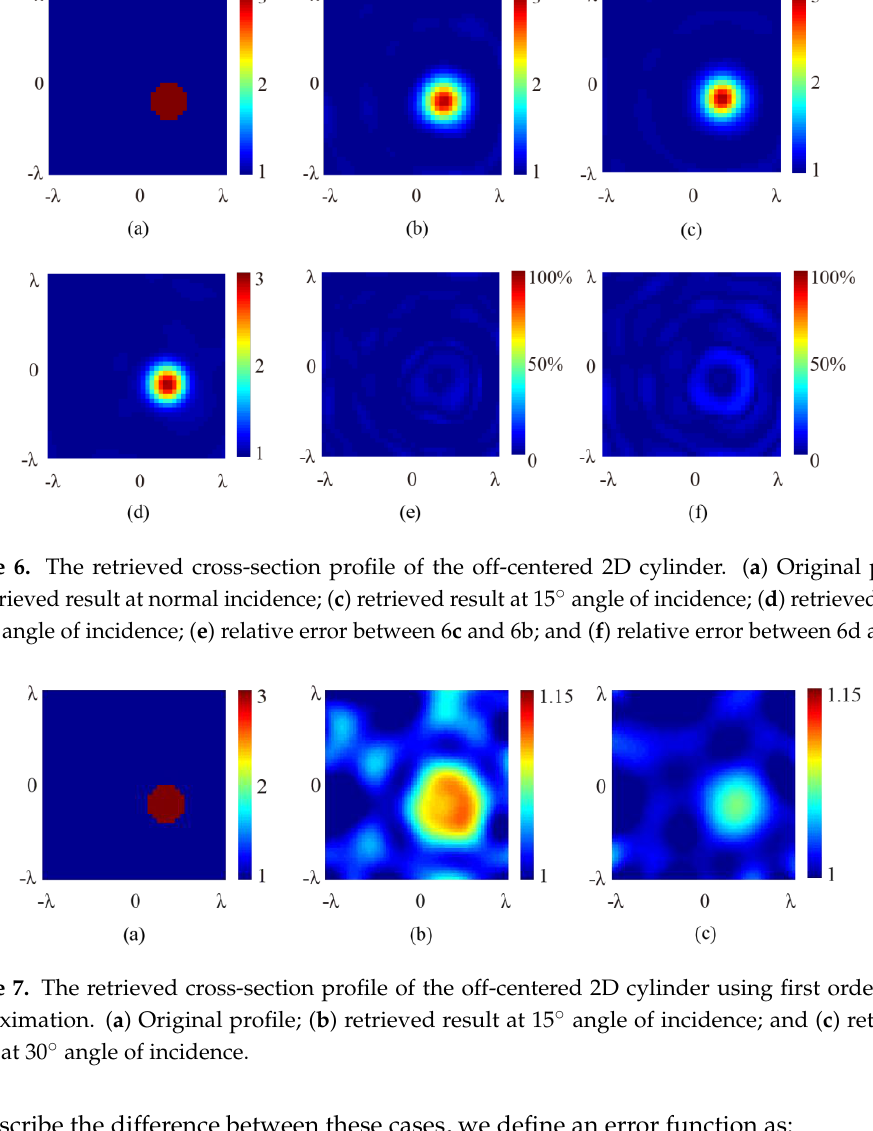
Figure 5. The retrieved cross-section profile of the centered 2D cylinder. ( a ) Original profile; ( b ) retrieved result at normal incidence; ( c ) retrieved result at 15° angle of incidence; ( d ) retrieved result at 30° angle of incidence; ( e ) relative error between 5c and 5b; and ( f ) relative error between 5d and 5b.